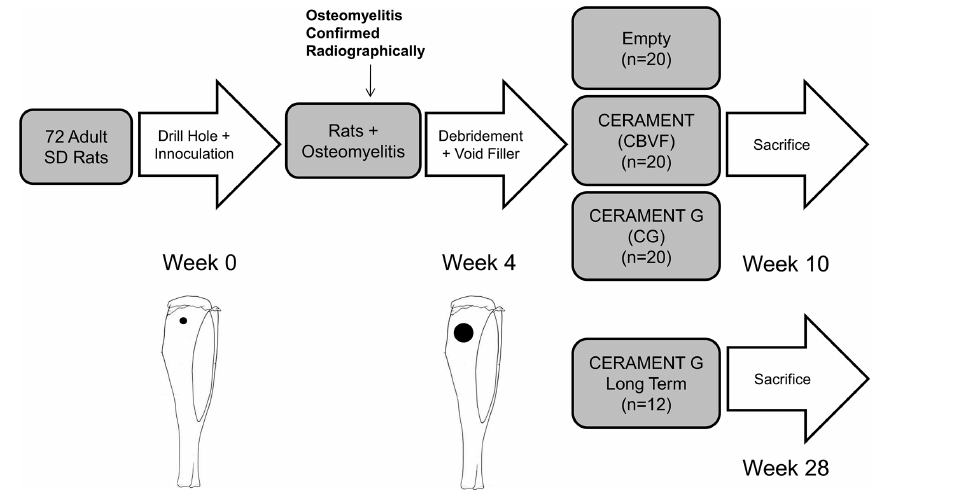
Figure 1. Study design: S. aureus (1 . 5 × 10 6 CFU) was injected into a drill hole in the right tibia of adult Sprague Dawley rats ( n = 72). After 3 weeks, the osteomyelitic defect was debrided and treated with (1) CERAMENT G ( n = 32), (2) CERAMENT ( n = 20), or (3) nothing ( n = 20); 6 weeks after the second surgery, 20 rats from each group were euthanized, and the right tibias were harvested. To determine the long-term outcome of the treatment, another group ( n = 12) of CERAMENT G-treated rats was also euthanized at 6 months after the debridement and